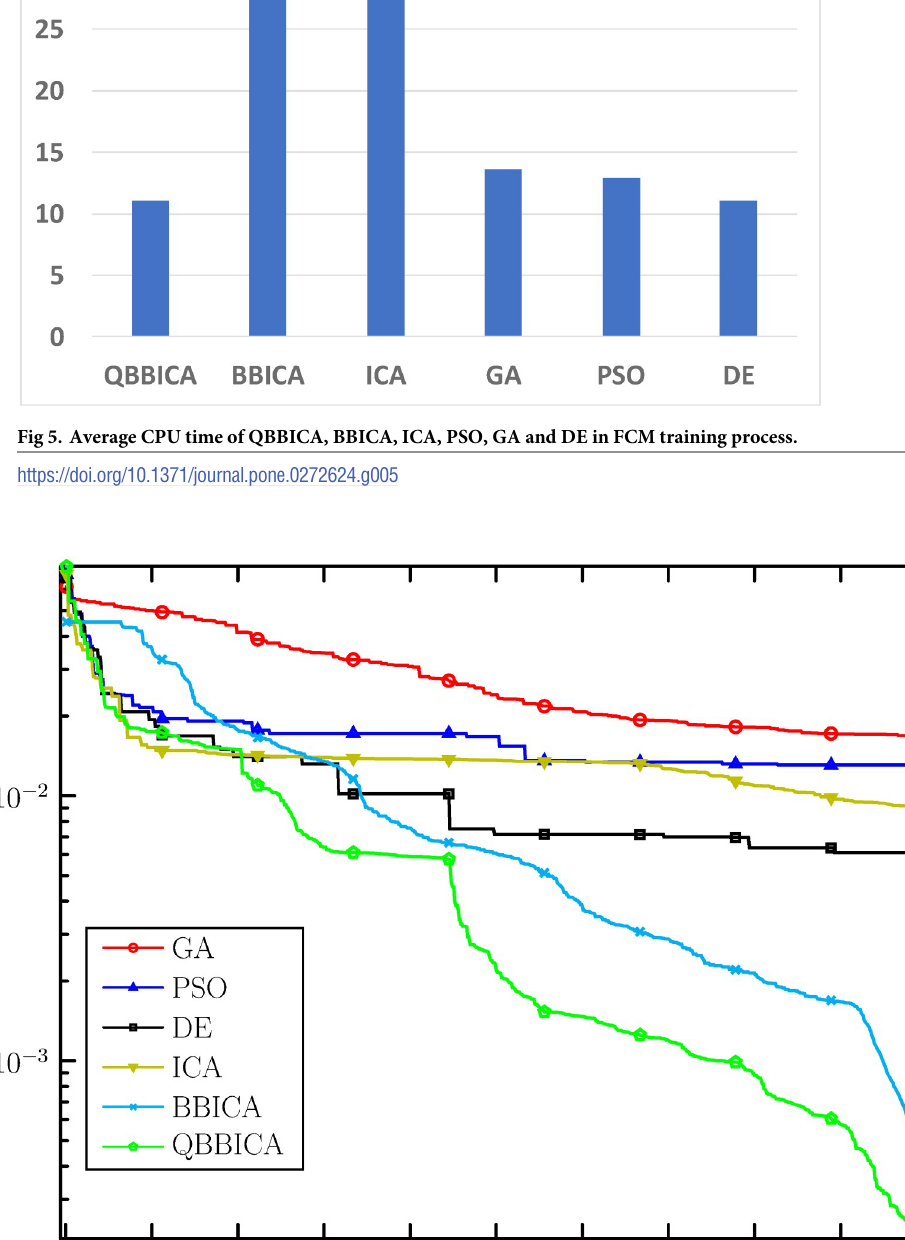
PLOS ONE | https://doi.org/10.1371/journal.pone.0272624 August 18,